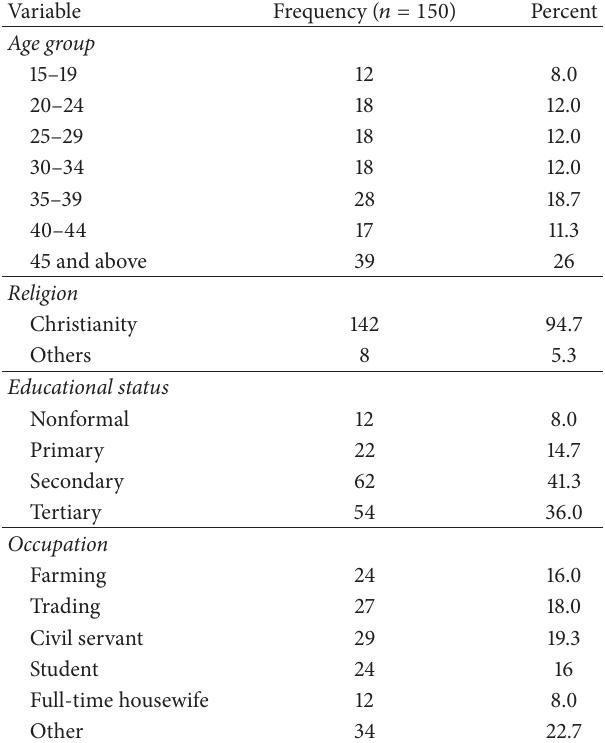
Table 1: Sociodemographic characteristics.